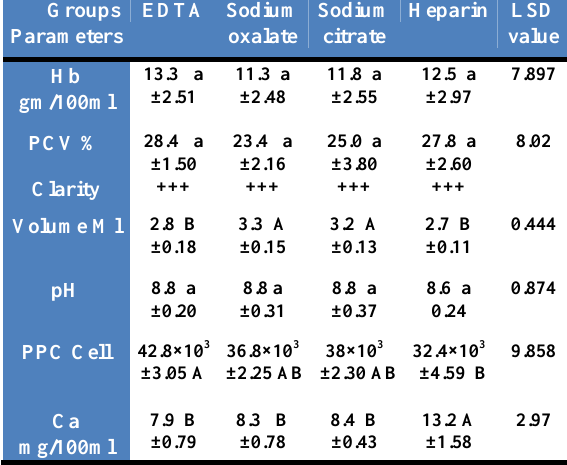
1: The effect of different types of anticoagulants on Haemoglobin, packed cell volume and plasma clarity, volume, pH, platelets count and calcium concentration of horse blood samples. Groups Parameters